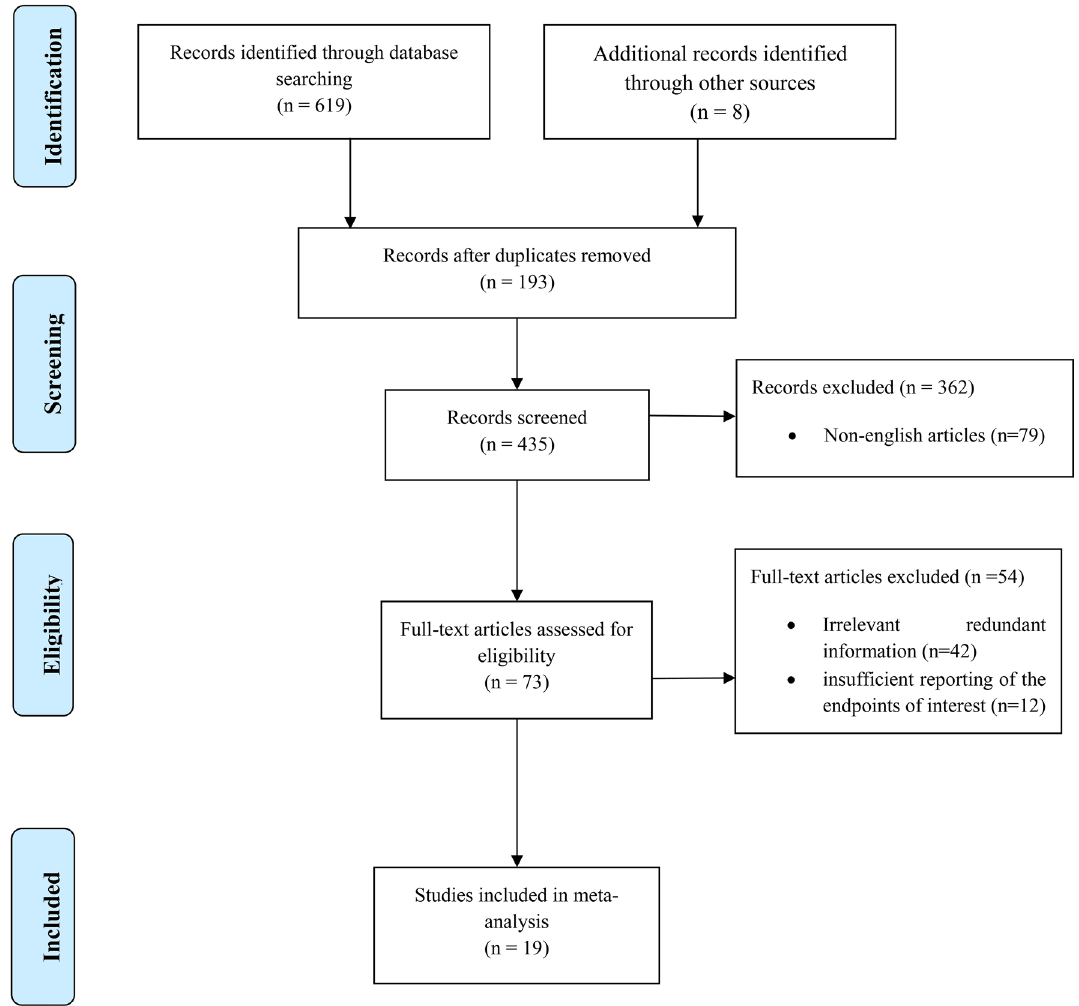
Figure 1. PRISMA flow chart of study